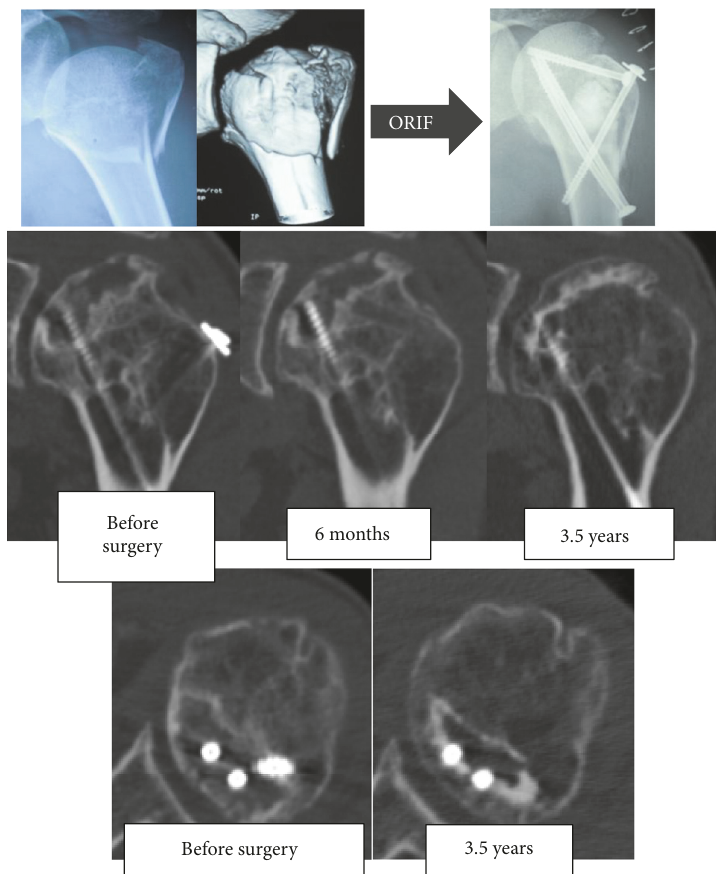
Figure 2: X-ray and computed tomography images of Case 2 .